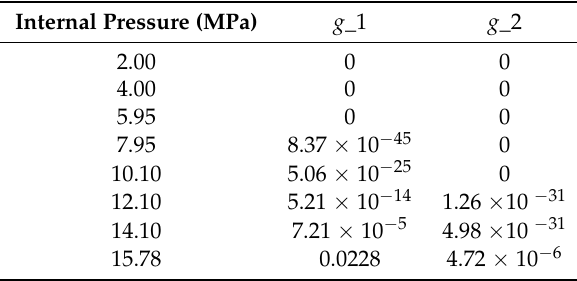
Table 4. The probability of failure of limit state g _1 & g _2.